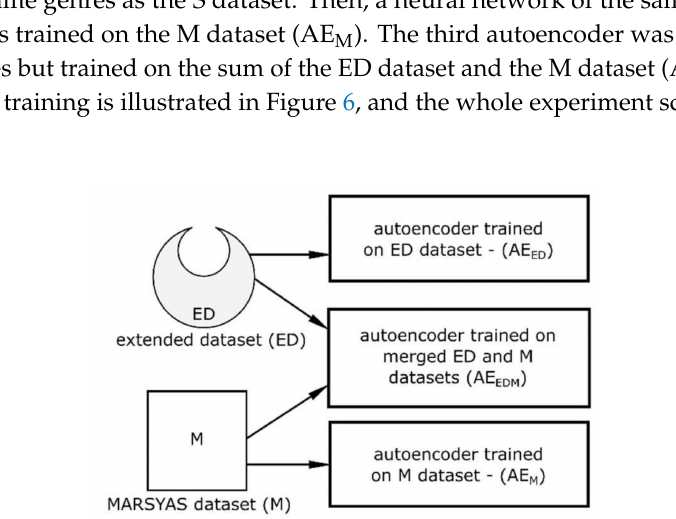
Figure 6. Graphical depiction of three autoencoder (AE) parametrization neural networks—the first one (AE ED ) is trained only on musical excerpts derived from the dataset containing excerpts which were not used for the survey (i.e., the ED set), the second one (AE M ) is trained only on excerpts from the MARSYAS set (M), and the third one (AE EDM ) was trained on merged examples derived from both the ED and M